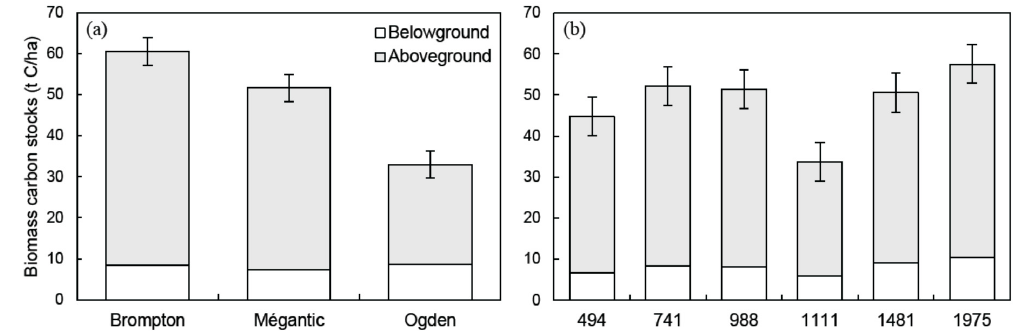
Figure 1. Site effect ( a ) and Planting density effect ( b ) on total biomass C stocks and its distribution between the belowground and aboveground compartments in 14 year-old hybrid poplar plantations. Vertical bars represent standard error of the mean for total C stocks in biomass. p -value for the Site effect are the followings: total biomass C ( p < 0.001), belowground biomass C ( p = 0.21) and